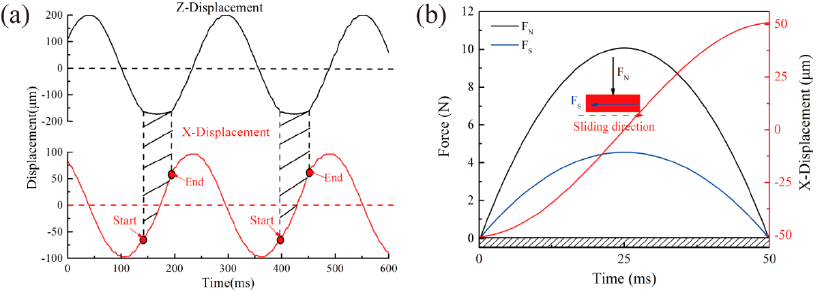
Figure 3. Movement and force conditions of both directions during each impact-sliding wear cycle: ( a ) Independent trajectory of each direction; ( b ) F-t diagram of each cycle.